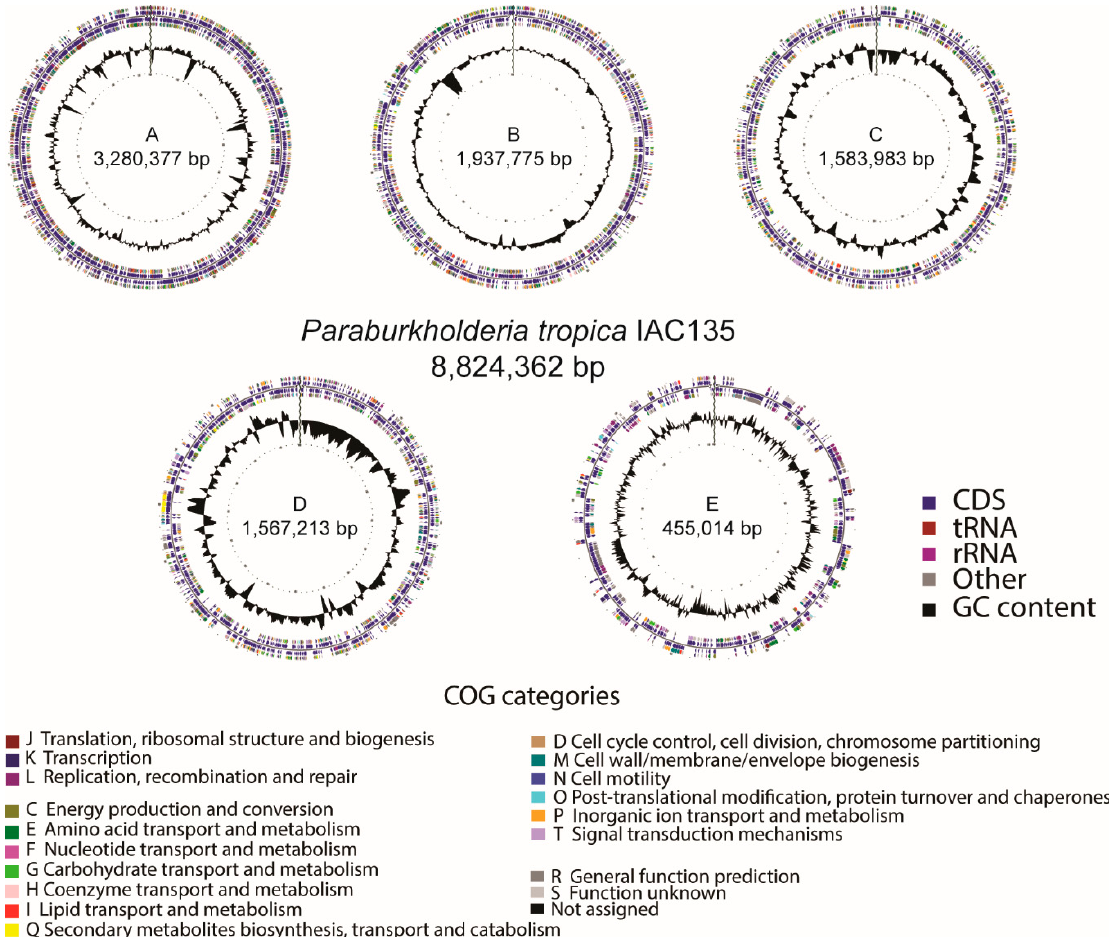
Figure 3. Graphical circular genome map of Paraburkholderia tropica strain IAC/BECa 135. The rings indicate coding sequences, Clusters of Orthologous Groups of proteins (COGs) categories, GC content, and GC skew.